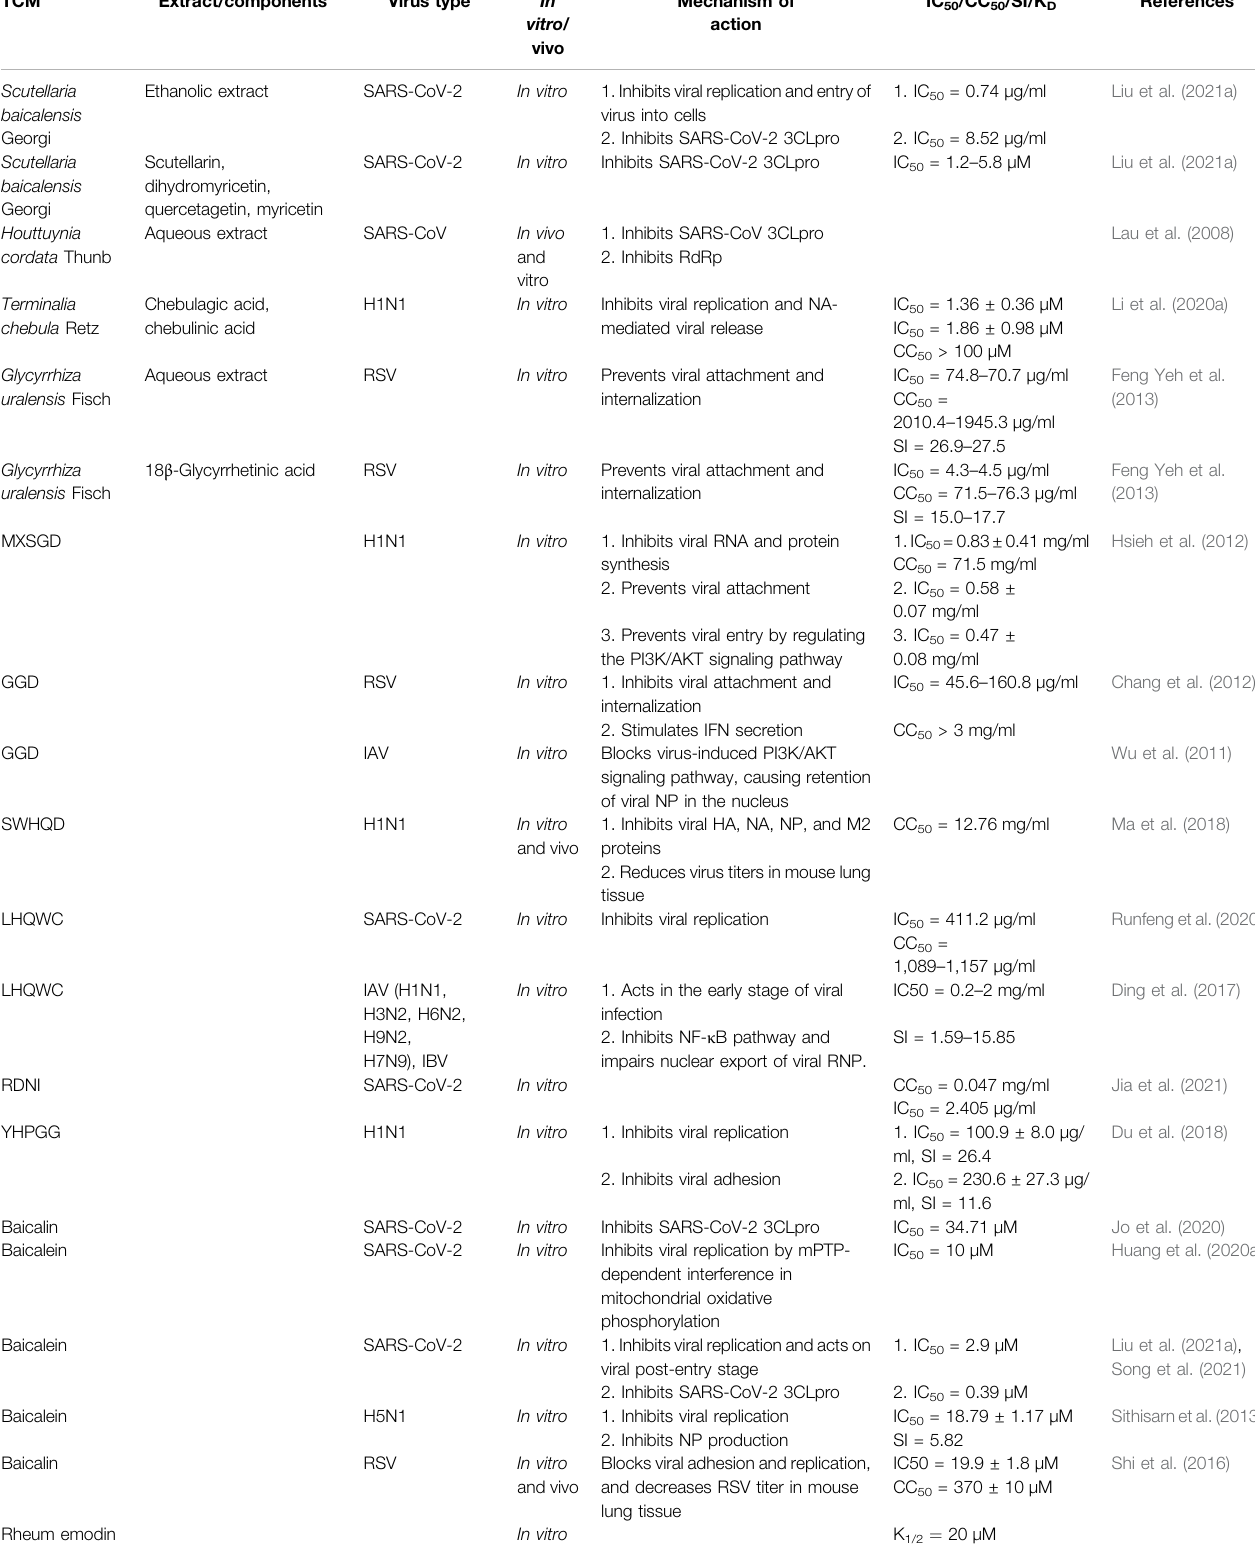
TABLE 2 | TCMs that target viruses